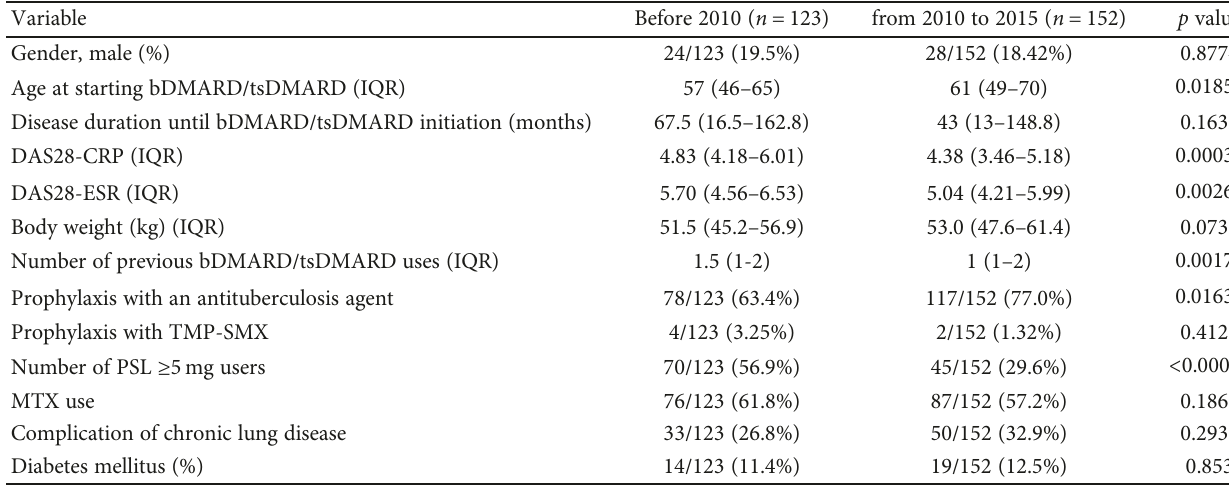
Table 4: Background of the patients with bDMARD/tsDMARD initiation before 2010 and from 2010 to